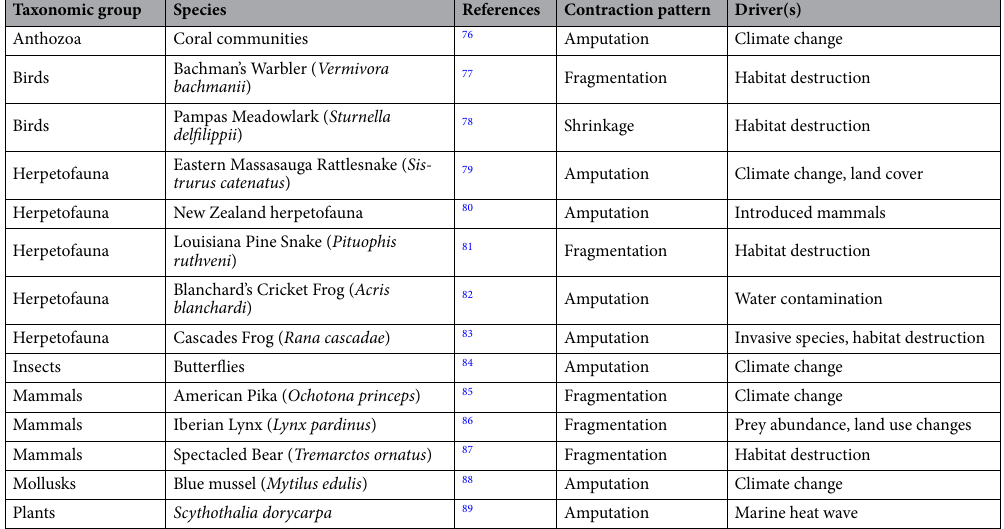
Table 1. Examples from the literature of range contractions in various taxa representing three patterns (amputation, shrinkage, and fragmentation), along with potential drivers of each contraction, as described by the authors of each